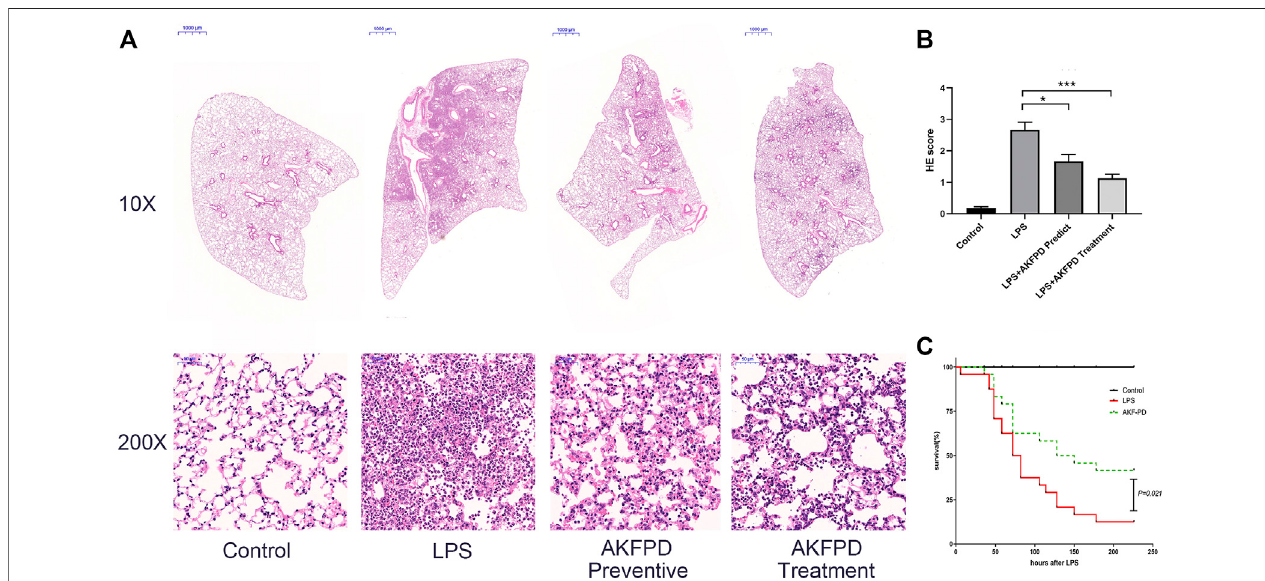
FIGURE 1 | Fluorofenidone treatment ameliorated lung injury and mortality in the LPS-induced ALI mouse model. An acute lung injury model was established by LPS (5 mg/kg, intratracheal injection). The lung tissue was collected 48 h after the LPS challenge. AKFPD was administered orally to observe the preventive and therapeutic effect ( n (cid:1) 6 per group). (A) Representative images of HE staining of the pathological changes in lung tissues from different groups (10 × magni fi cation, scale bar (cid:1) 1000 μ mand200 × magni fi cation, scalebar (cid:1) 50 μ m). (B) Thelunginjury scoresofHE stainingforpulmonarydamage.Each unit randomly chose10scopes under 200 × magni fi cation to calculate the average values. (C) Analysis of the survival rate of ALI mice induced by LPS ( n (cid:1) 12 per group). Data were represented as mean ± SD. * p < 0.05 and *** p < 0.005 vs. LPS group.